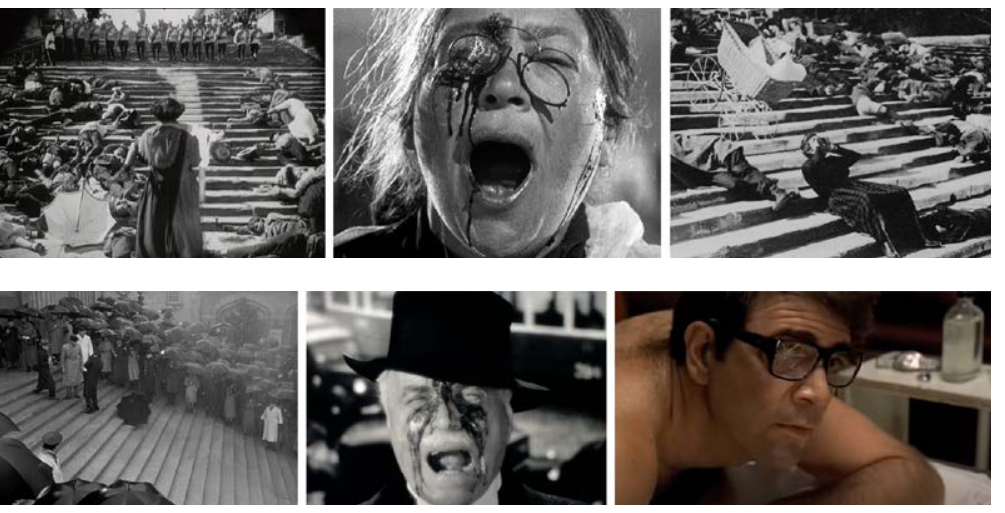
Fig. 2 Alfred Hitchcock, Foreign Correspondent , 1940 (left,